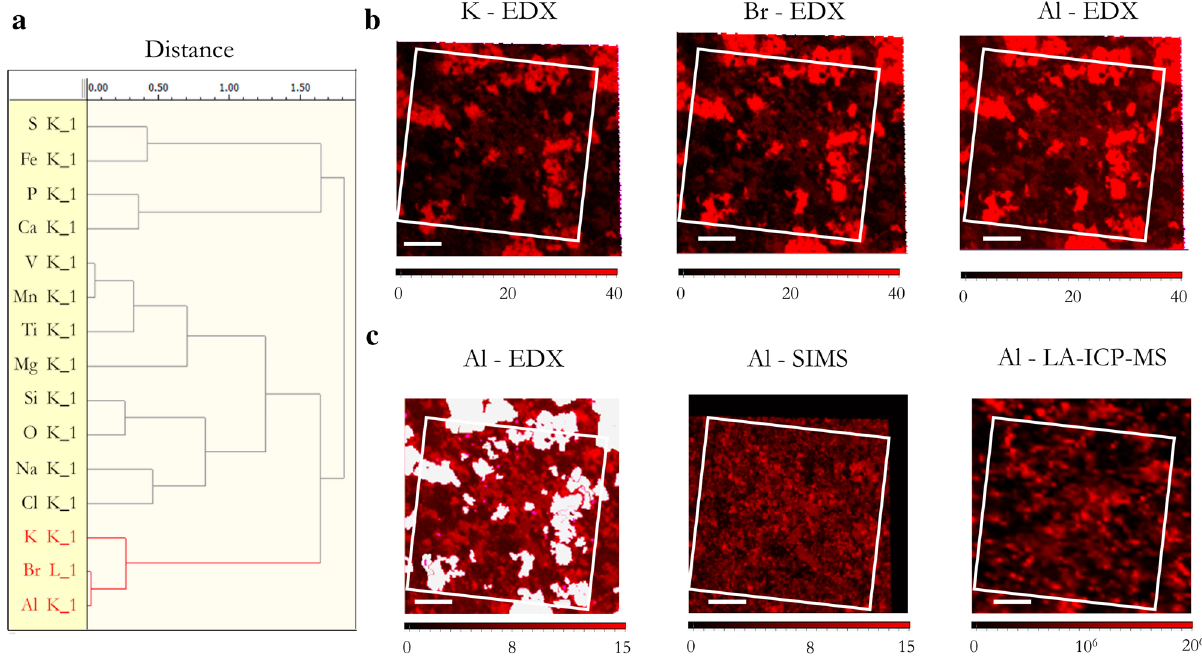
Figure 3. ( a ) Dendrogram obtained from HCA of the first 5 PCs of SEM–EDX SPDCs of NU-A sample. Comparison of spatial distribution for EDX of ( b ) potassium (K), bromide (Br), and aluminium (Al), and ( c ) Al spatial distribution detected by the three elemental techniques with the KBr mask being applied to EDX data (white areas). Common analysis area is marked with a white square. Scale bars correspond to 100 μm.